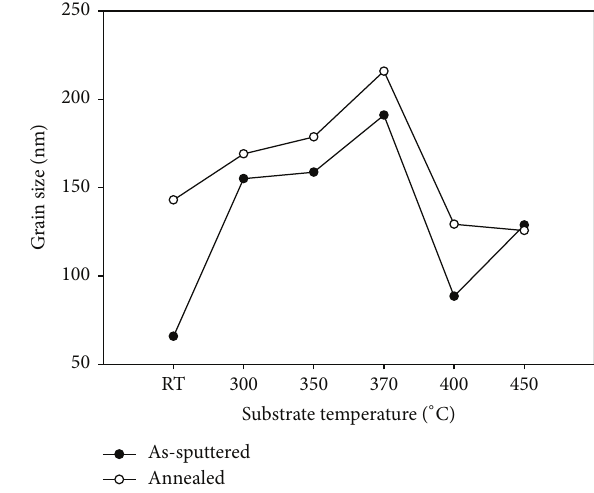
Figure 6: Surface roughness of as-sputtered and annealed films analyzed by AFM measurement.